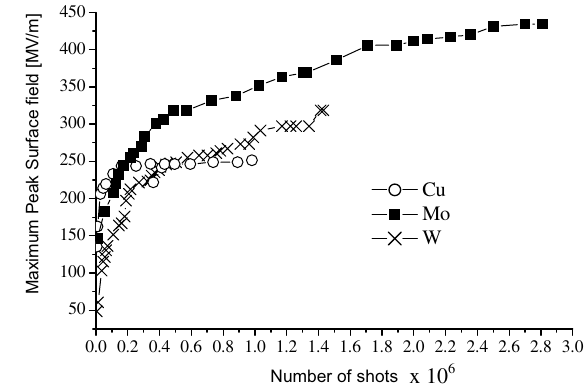
FIG. 10. Conditioning curves with maximum surface rf field, corresponding to 2.2 times the accelerating field, as a function of the number of pulses measured for CTF2 for accelerating structures of Cu, Mo, and